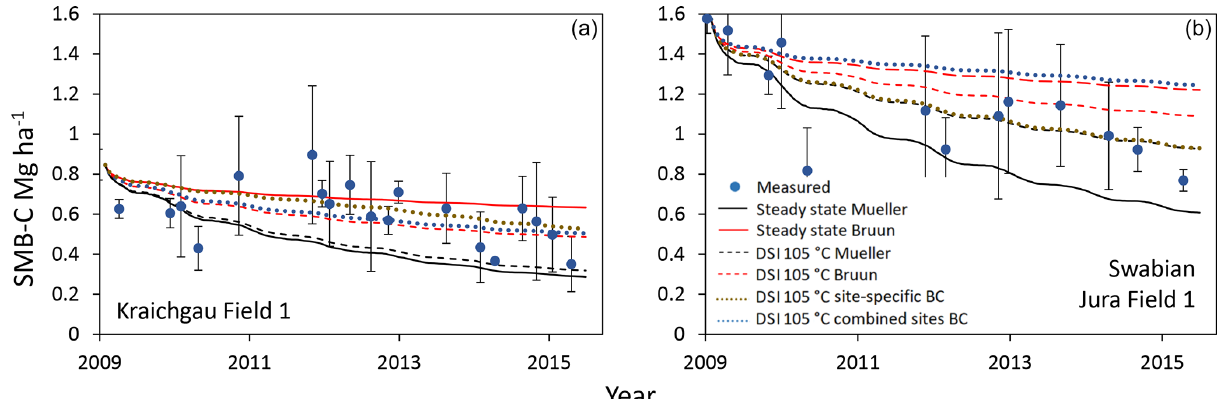
Figure 4. Example SMB-C simulations for Kraichgau Field 1 (a) and Swabian Jura Field 1 (b) . Initializations were carried out (i) assuming a steady state using the formula of Bruun and Jensen (2002) with turnover rates of Mueller et al. (1997) and Bruun et al. (2003) and (ii) by the DRIFTS stability index (DSI) at a 105 ◦ C drying temperature using both turnover rates for simulations (simulations using the other drying temperatures for DRIFTS are in the supplementary material). The site-specific and the combined-sites Bayesian calibrations (BC) are also displayed. Bars indicate the standard deviation of measured values of all plots ( n = 3) per